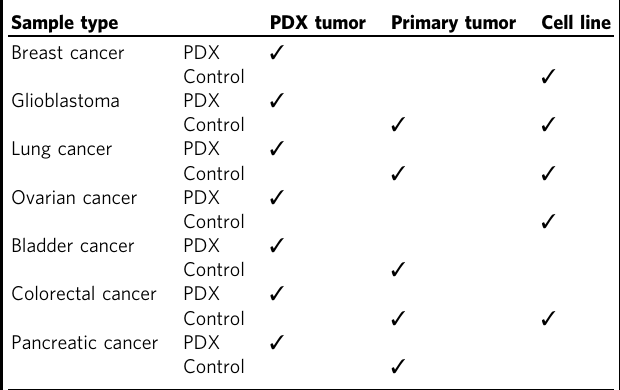
Table 1 Sample origins of sequenced PDX tumors and non- PDX